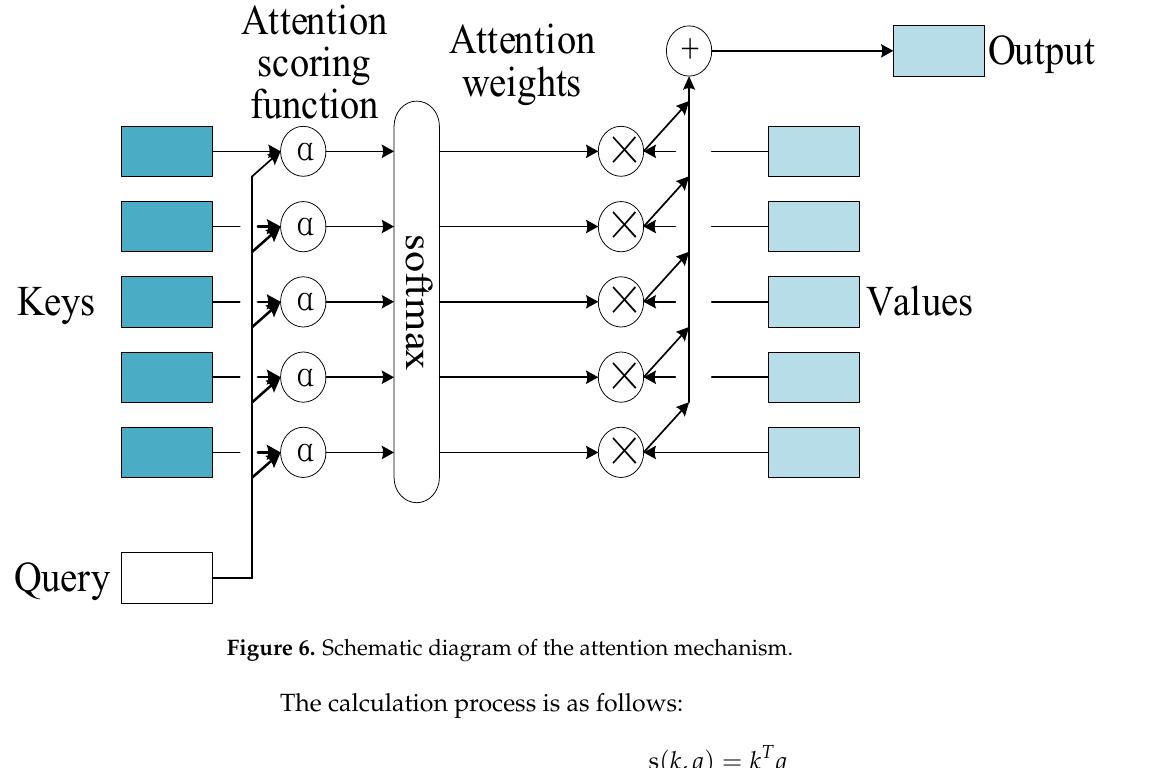
Figure 6. Schematic diagram of the a tt ention mechanism.